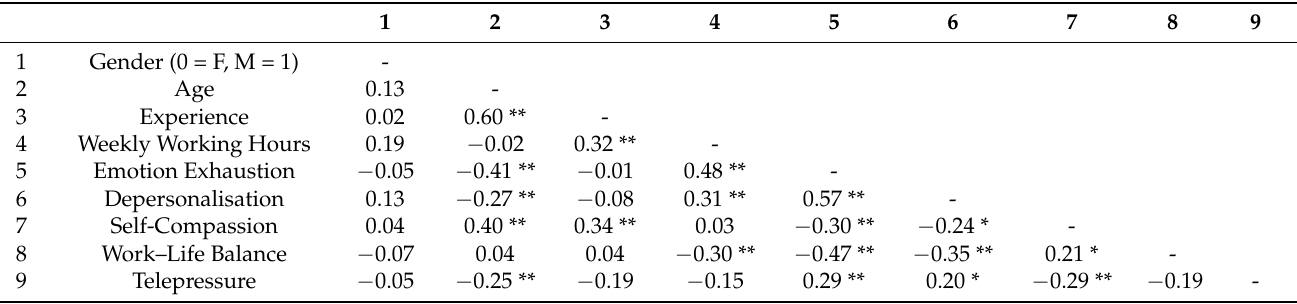
Table 2. Correlations among burnout, self-compassion, work–life balance and telepressure in professional psychotherapists ( n = 106).